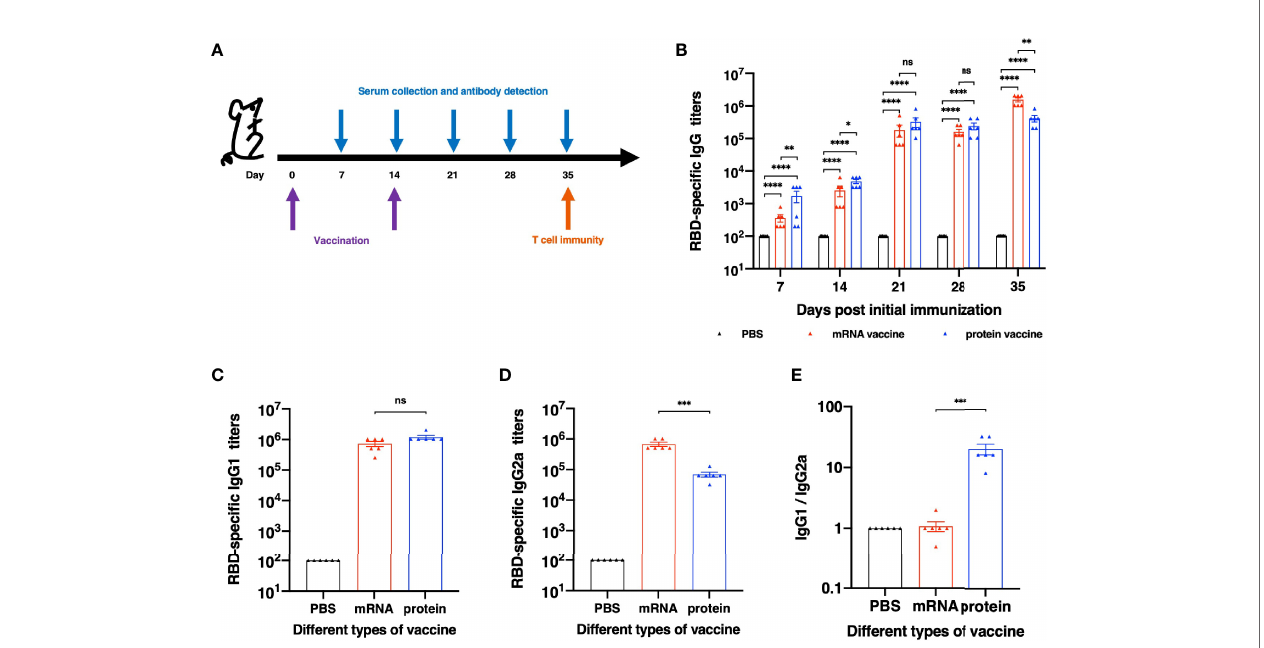
FIGURE 2 | Humoral Immune Response results of different vaccines. (A) Schematic diagram of immunization and sample collection schedule. (B) SARS-CoV-2- speci fi c IgG antibody titers. (C) SARS-CoV-2 RBD-speci fi c IgG1 (Th2) titers and (D) IgG2a (Th1) titers of each vaccination group. (E) The ratios between speci fi c IgG1 and IgG2a antibody responses. The antibody titers were expressed as the endpoint dilutions that remain positively detectable. The data are presented as mean ± SEM from six mice in each group. PBS was included as the control. Signi fi cance was calculated using unpaired t test (ns, not signi fi cant; *p < 0.05, **p < 0.01, ***p < 0.001, ****p < 0.0001).